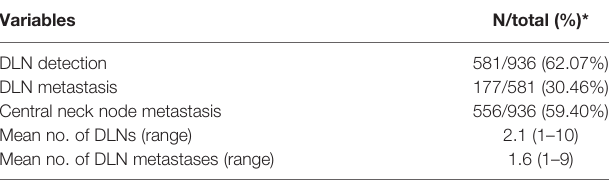
TABLE 1 | Rates of Delphian lymph node (DLN) detection and metastasis. Variables